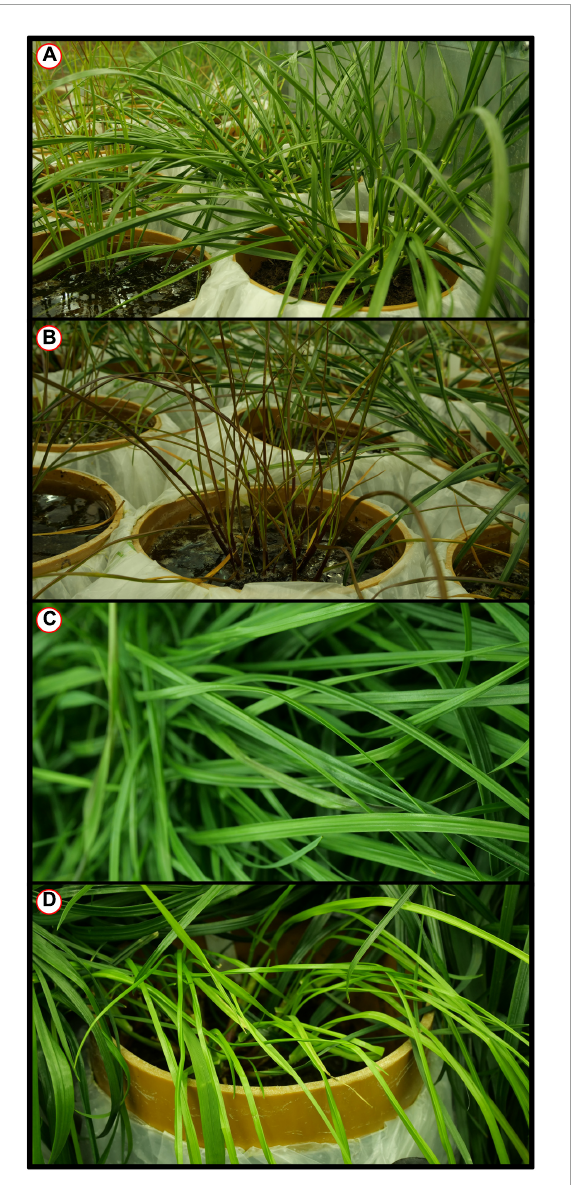
FIGURE1 Perennial Ryegrass ( Lolium perenne ) whole plant appearance examples images for selected harvests and water status. (A) DAS 72 non-waterlogged. (B) DAS 72 waterlogged. (C) DAS 101 non-waterlogged. (D) DAS 101 waterlogged. Examples images are not color